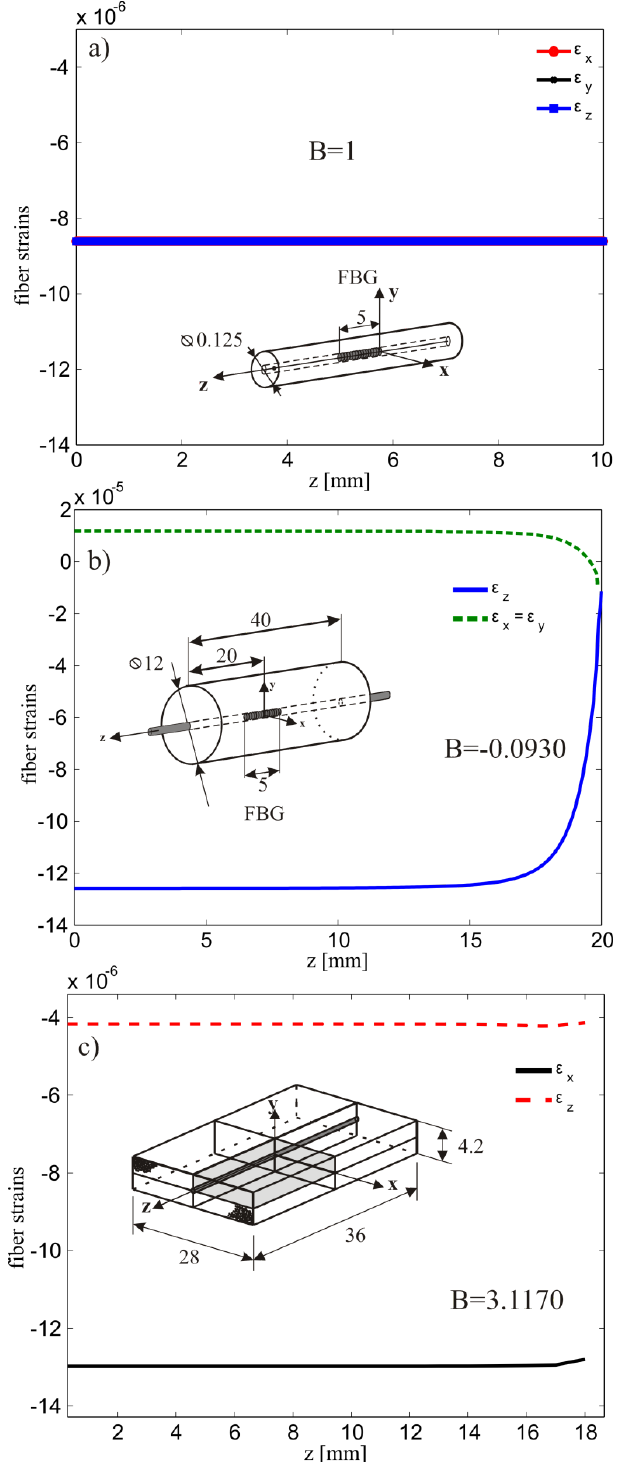
Figure 5. Simulated strains in the fiber core in the case of, ( a ) bare fiber, ( b ) embedded in an epoxy cylinder, ( c ) embedded in a composite. The pressure is 1 MPa and the units are